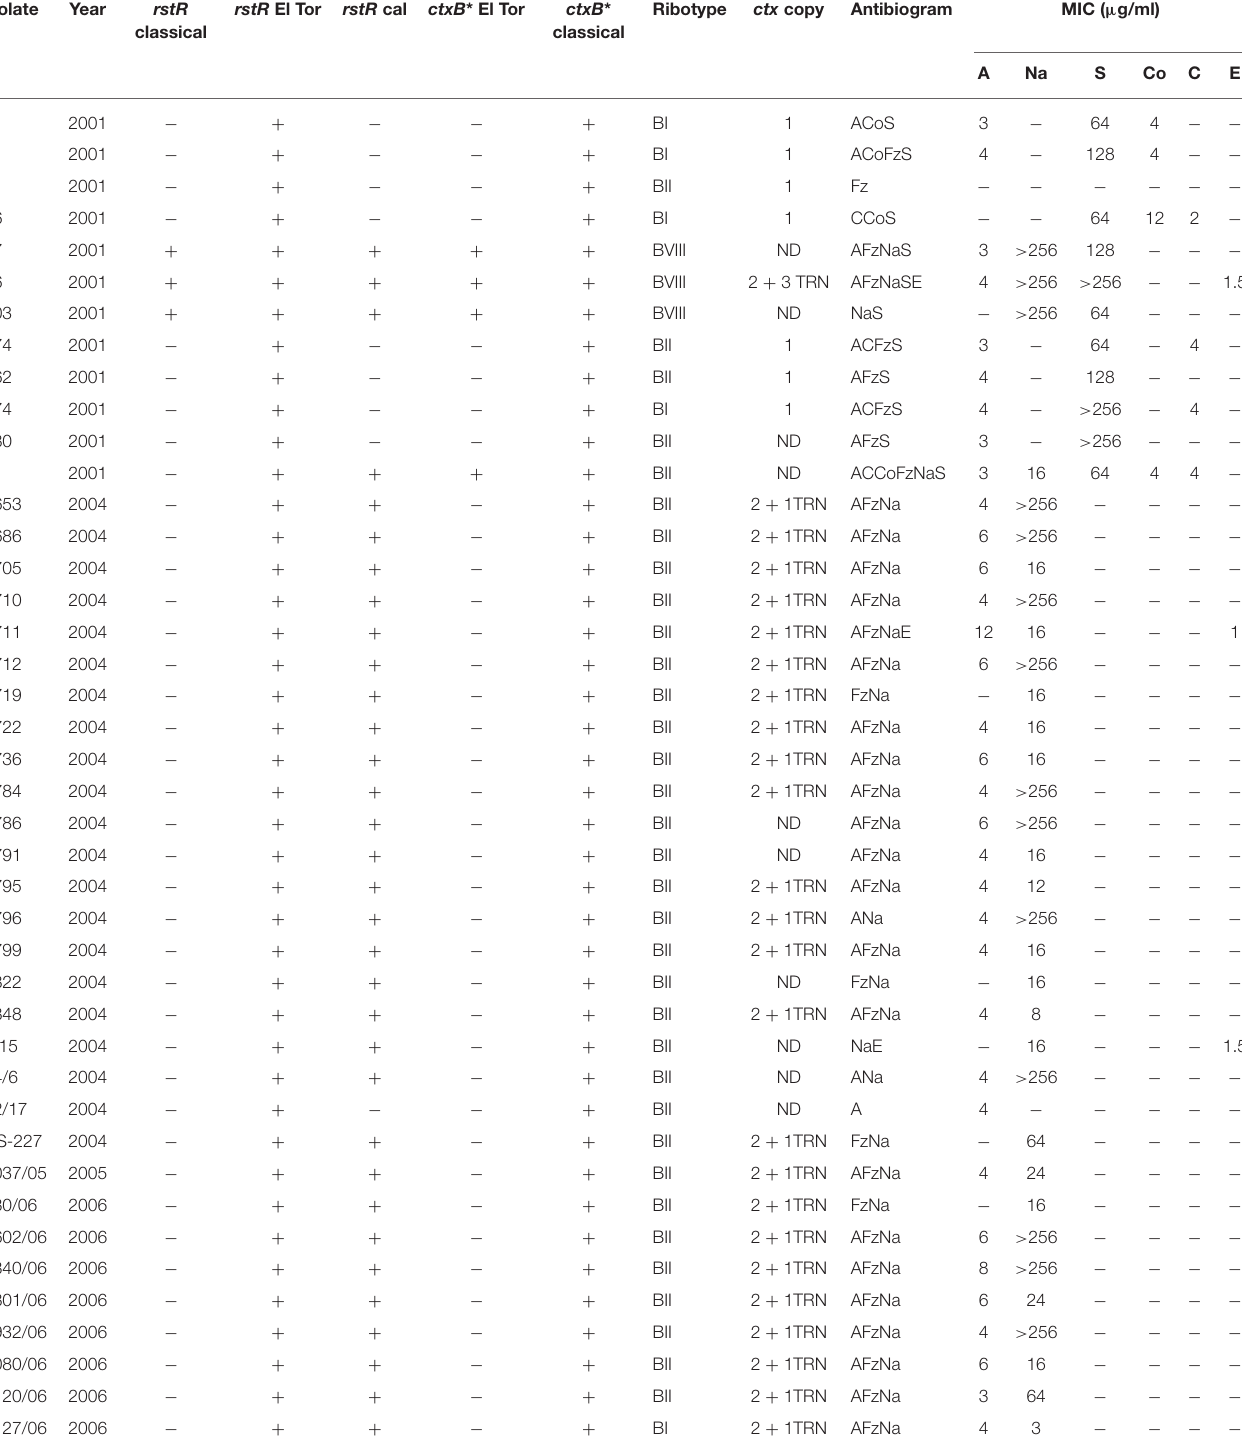
TABLE 1 | Phenotypic and genetic characteristics of V. cholerae O139 isolates.